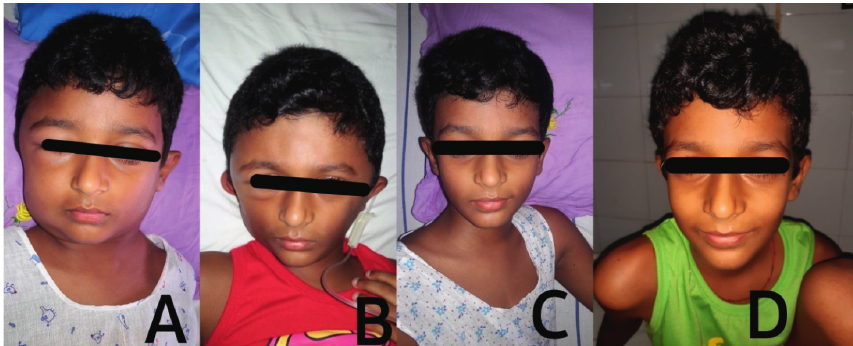
Figure 1: A series of photographs of the child demonstrating severe, disfiguring scalp and facial oedema and its gradual resolution.